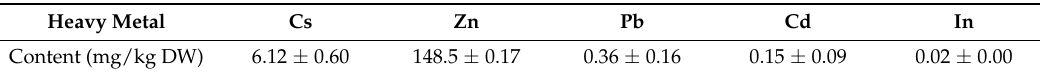
Table 2. Basal contents of heavy metals in aseptically cultured E. acicularis . These results were measured with ICP-MS. Dry weight to 10 g fresh weight was 750 ± 52 mg ( n = 2, ±